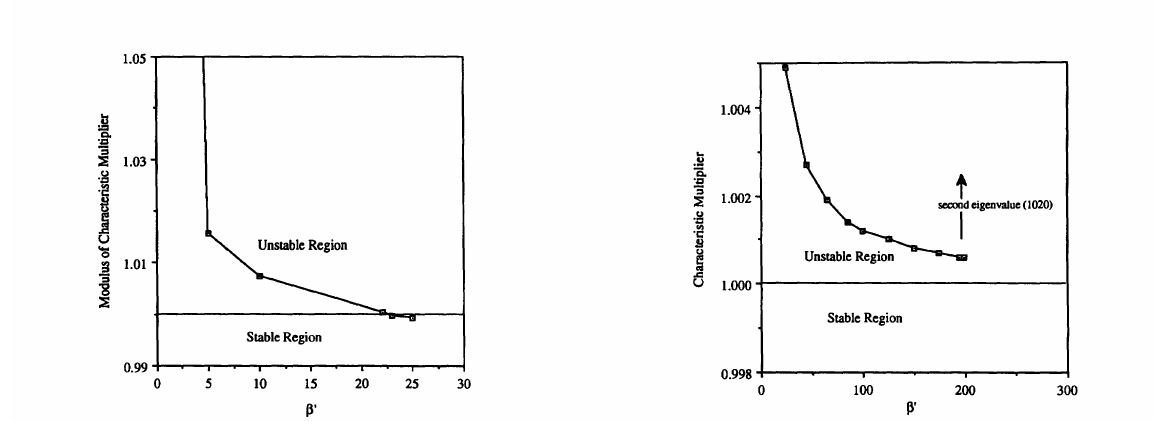
FIGURE 5 Modulus of characteristic multiplier ver sus {3' (eli = 1.0 case).